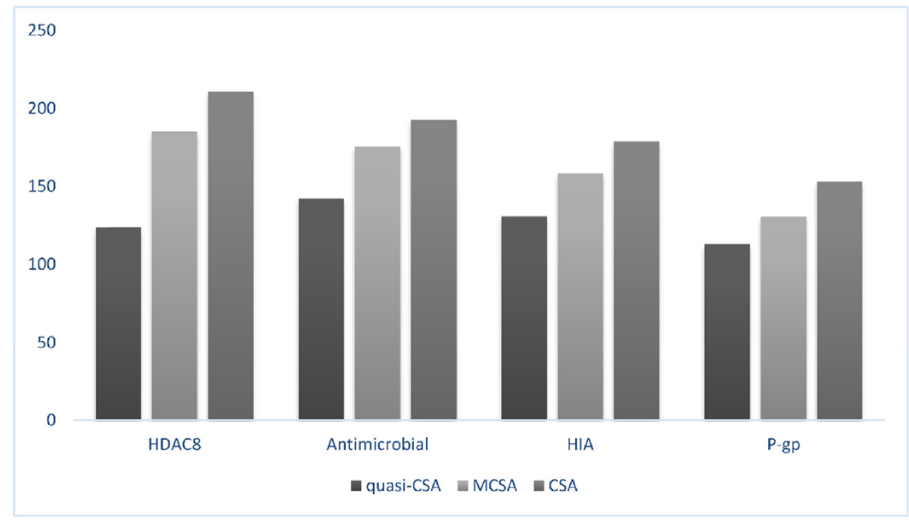
Figure 3: The average training time in seconds for the BCSA - QO, M - CSA, and S - CSA